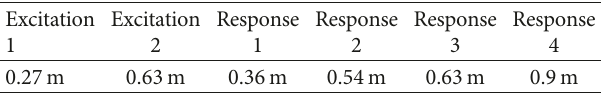
Table 2: Distances between each measuring point and the fixed end.